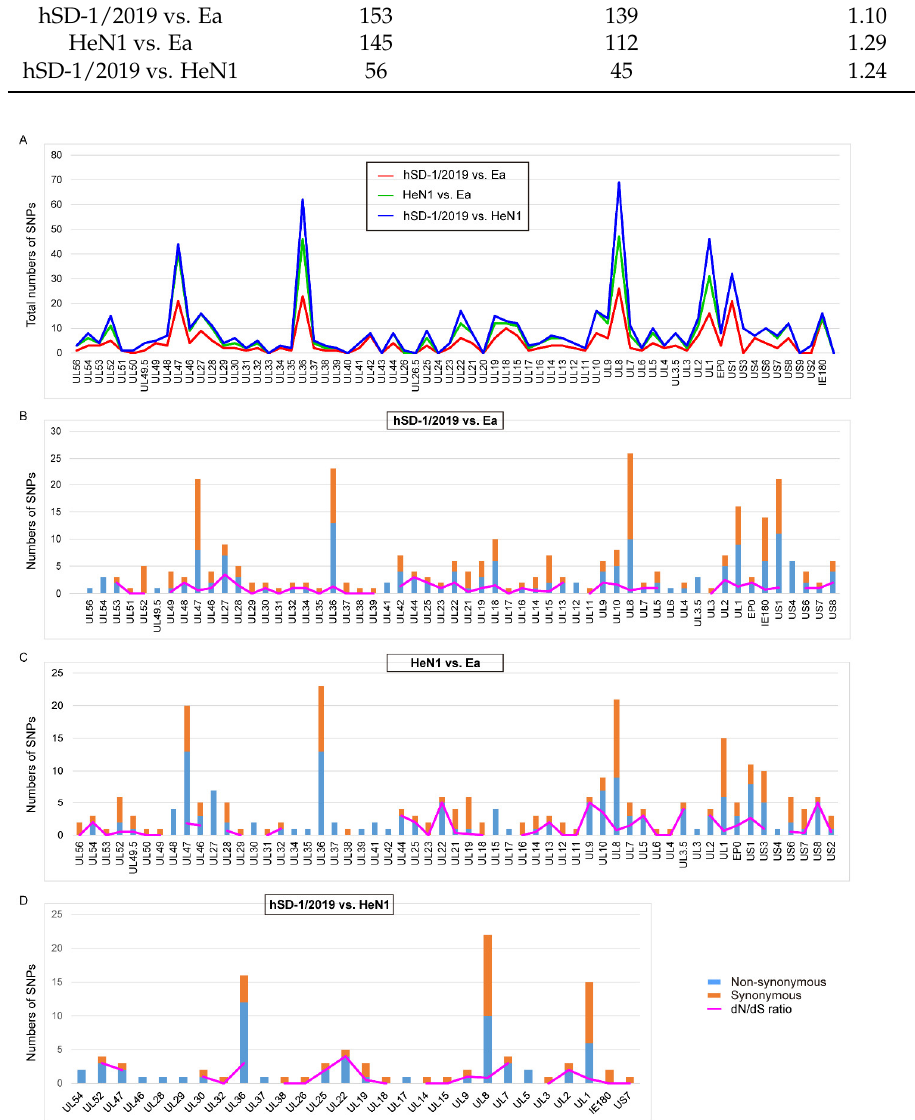
Figure 4. Single-nucleotide polymorphisms (SNPs) of the human- and pig-originated PRV strains ( A ) Graph showing the numbers of total SNPs identified in the complete genome sequences of human-originated PRV strain hSD-1/2019 and pig-originated PRV variant strain HeN1 compared to those of strains Ea and/or HeN1, respectively. ( B ) Graph showing the numbers of non-synonymous SNPs and synonymous SNPs, as well as the ratio of non-synonymous to synonymous substitutions (dN/dS) in the complete genome sequences of hSD-1/2019 compared to that of Ea. ( C ) Graph showing the numbers of non-synonymous SNPs and synonymous SNPs, as well as the dN/dS ratio in the complete genome sequences of HeN1 compared to that of Ea. ( D ) Graph showing the numbers of non-synonymous SNPs and synonymous SNPs, as well as the dN/dS ratio in the complete genome sequences of hSD-1/2019 compared to that of